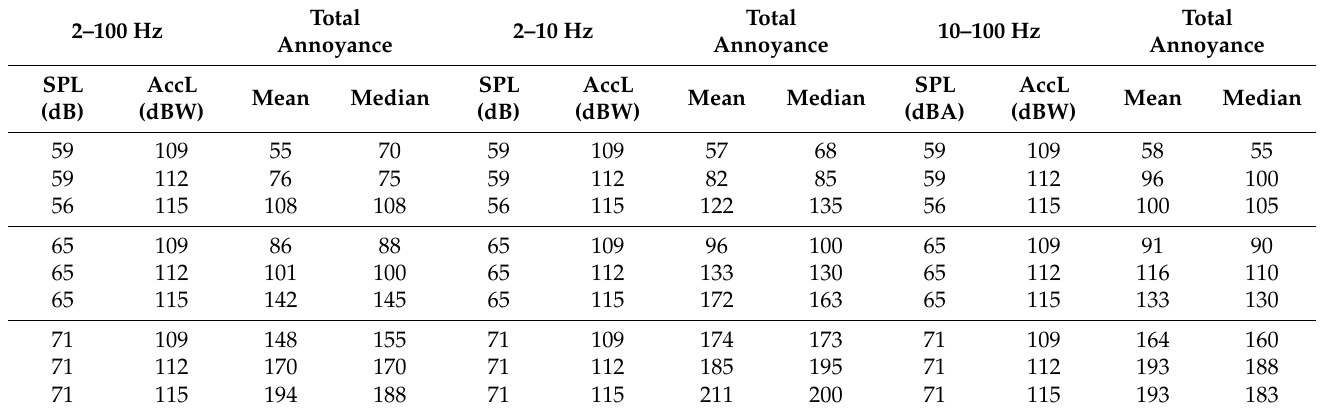
Table 2. Geometric mean and median values of the annoyance ratings of the refuse collection vehicle scene.